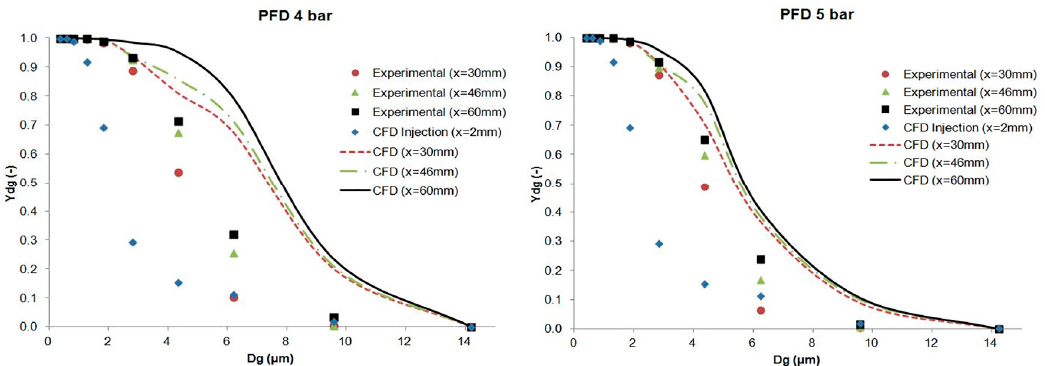
Figure 11. Experimental and numerical axial air velocity profiles at different distances from the catheter tip.